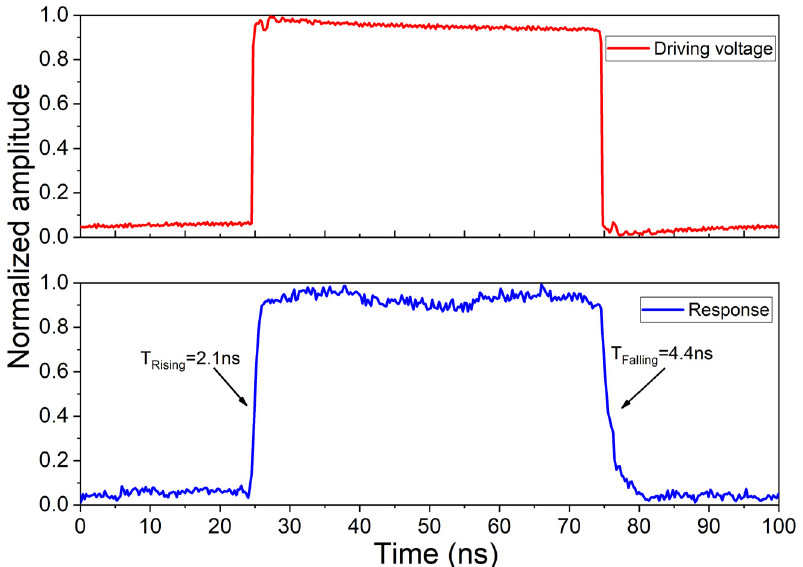
Figure 9: The driving signal and dynamic response of the